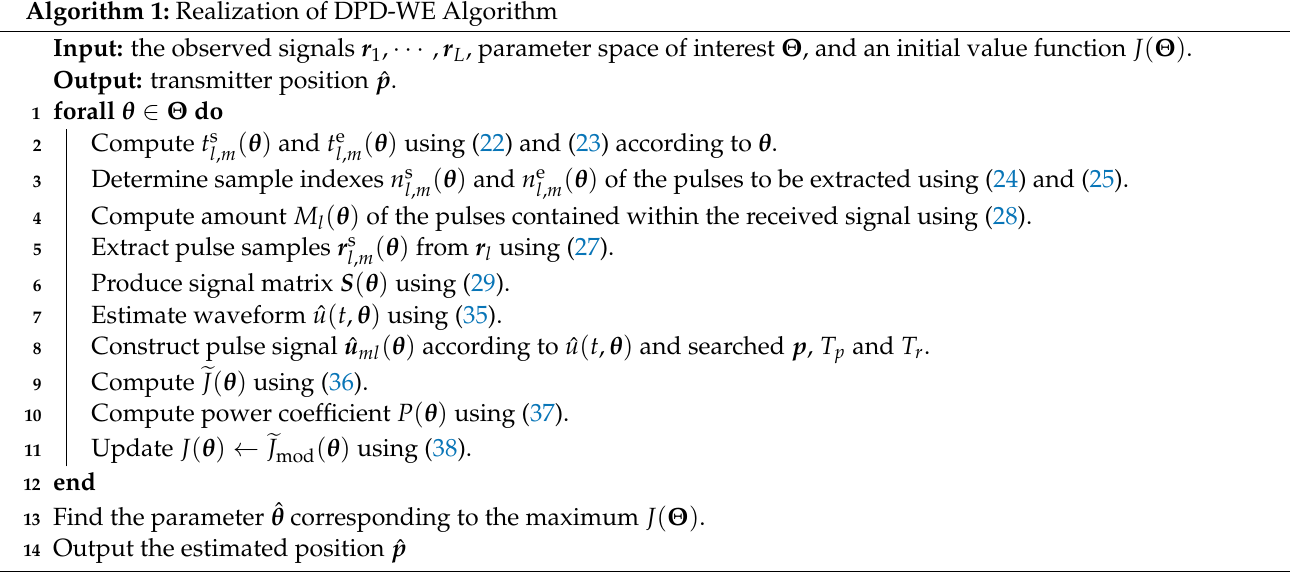
Algorithm 1: Realization of DPD-WE